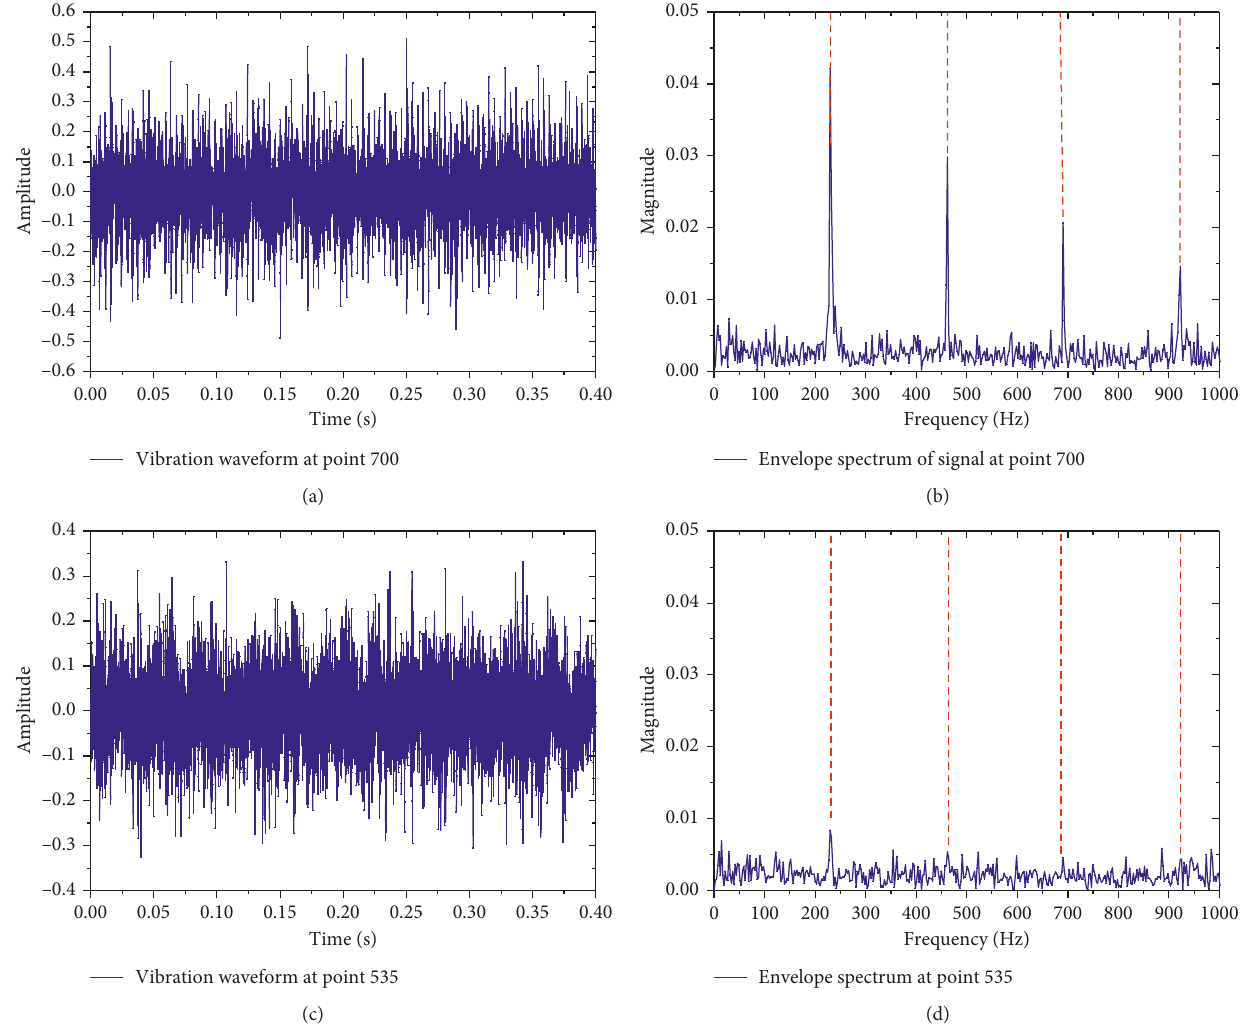
Figure 8: The start and end of stage II: (a) waveforms of signal at point 700; (b) envelope spectrum of signal at point 700; (c) waveforms of signal at point 535; (d) envelope spectrum of signal at point 535.